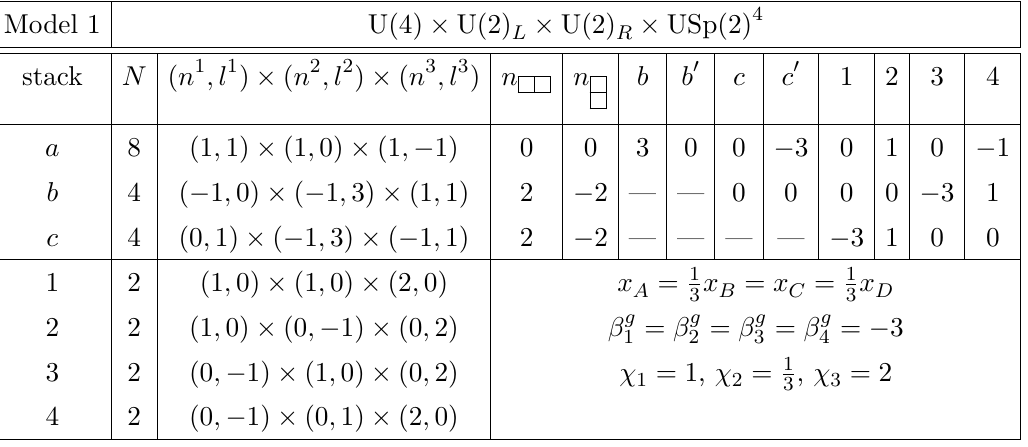
Table 8 . D6-brane configurations and intersection numbers of Model 1, and its gauge coupling